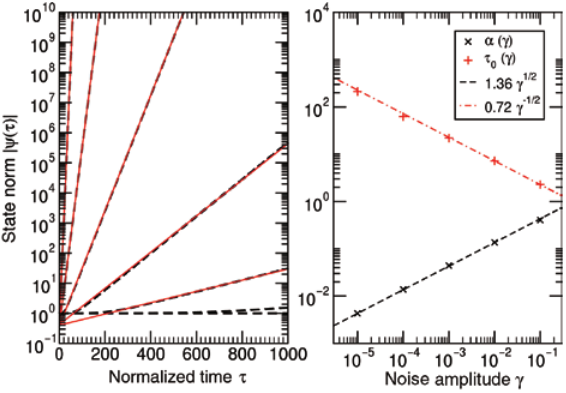
Figure 1: Left panel: Double-logarithmic plot of the norm | ψ ( τ ) | of the state starting with the exceptional-point eigenstate (0) (1, i) / 2 T ψ = for different values of γ (see graph annotations). The black dashed curves are the numerical solutions to the effective differential equation (10a–10c) using fourth-order Runge-Kutta integration. The red and blue solid lines are brute-force calculations of Eq. (12) modeling the noise as two quite different ensembles consisting of 1000 harmonic oscillators each (red curve, high- frequency noise; blue curve, low-frequency noise; see Appendix B for details). Right panel: Same as left panel starting with the non-eigenstate ψ (0) = (0, 1) T .